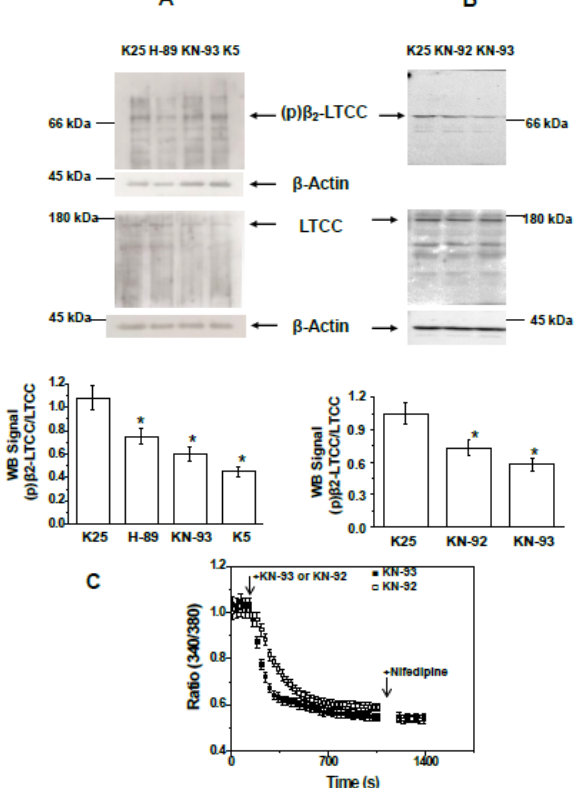
Figure 3. H-89 and KN-93 decrease the phosphorylation of the β 2 subunit of LTCCs to values measured in proapoptotic MLocke’s K5. ( A ) CGNs in MLocke’s K25 were incubated for 15 min at 37 ◦ C in a 5% CO 2 culture chamber with 20 µ M H-89, 30 µ M KN-93, or in the absence of these inhibitors (K25 control), or after CGN incubation for 1 h at 37 ◦ C in the 5% CO 2 culture chamber in the proapoptosis MLocke’s K5 condition (K5). ( B ) CGNs in MLocke’s K25 were incubated for 15 min at 37 ◦ C in the 5% CO 2 culture chamber with 30 µ M KN-92, 30 µ M KN-93, or in the absence of these inhibitors (K25 control). After SDS-PAGE (7.5% acrylamide), the proteins were transferred to PVDF membranes for Western blotting as indicated in Materials and Methods. For panel B, the PVDF membrane was stripped twice to remove primary antibodies—anti- β 2 subunit of LTCCs and anti-LTCC α 1C subunit—and used afterward for β -actin detection. The results shown in these panels are representative of the results obtained in triplicate experiments with different CGN preparations. The position of the molecular weight marker bands closest to the target proteins of the primary antibodies, i.e., β 2 subunit of LTCC, LTCC α 1C subunit, and β -actin, are shown at the left or right side of the corresponding PVDF membrane images. Western blots were revealed by exposure to autoradiography films for ( A ) and with ChemiDoc TM XRS+ from Bio-Rad for ( B ). The phosphorylation levels of the β 2 subunit of LTCCs , (p)β 2 LTCC/LTCC, shown in the bar graphs of panels A and B, were measured as indicated in the legend for Figure 1 and are average results ± S.E. of triplicate experiments. (*) p < 0.05. ( C ) Time dependence of population averages of the 340/380 ratio in neuronal somas before and after the addition of 30 µM KN-93 (black-filled squares) or 30 µM KN-92 (white- filled squares) at the point indicated by the first arrow. At the point indicated by the second arrow, 10 µM nifedipine was added. Mature CGNs in culture were loaded with Fura-2, as indicated in the Materials and M ethods section, and then changed to MLocke’s K25 buffer (37 °C) to start serial 340 and 380 image acquisition. Data acquisition was done as indicated in the Materials and Methods section, with exposure times lower than 0.4 s at time intervals of 30 s. The 340/380 ratio of neuronal somas was measured using the region of interest (ROI) tool of the HCImage software. The 340/380 ratio values shown are the average ± S.E. of experiments done with three different preparations of CGNs (n > 300 neuronal somas of fields taken from six plates for each experimental condition).